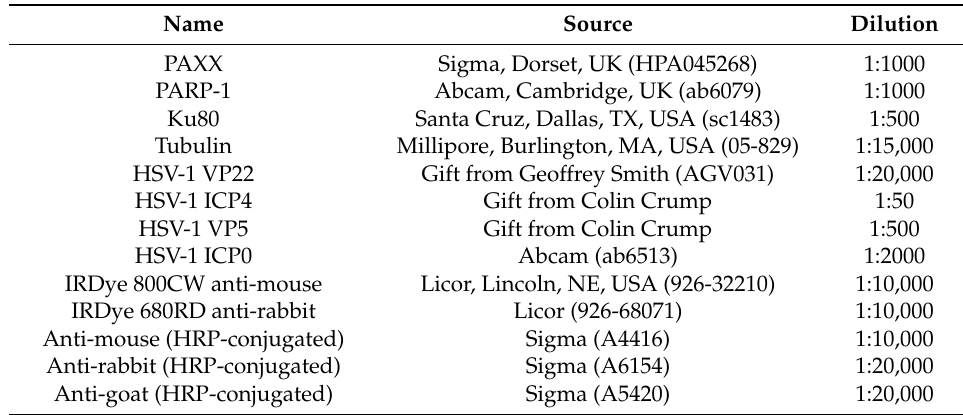
Table 3. Antibodies used in this